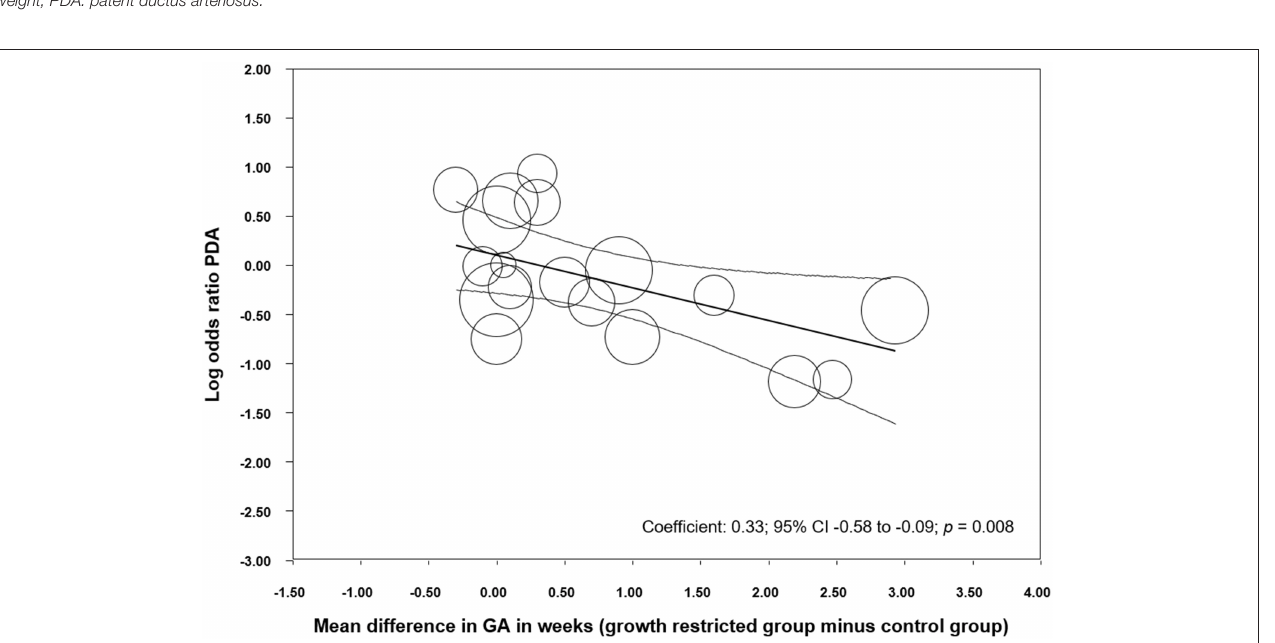
between SGA/IUGR and RDS ( p = 0.287, R 2 analog: